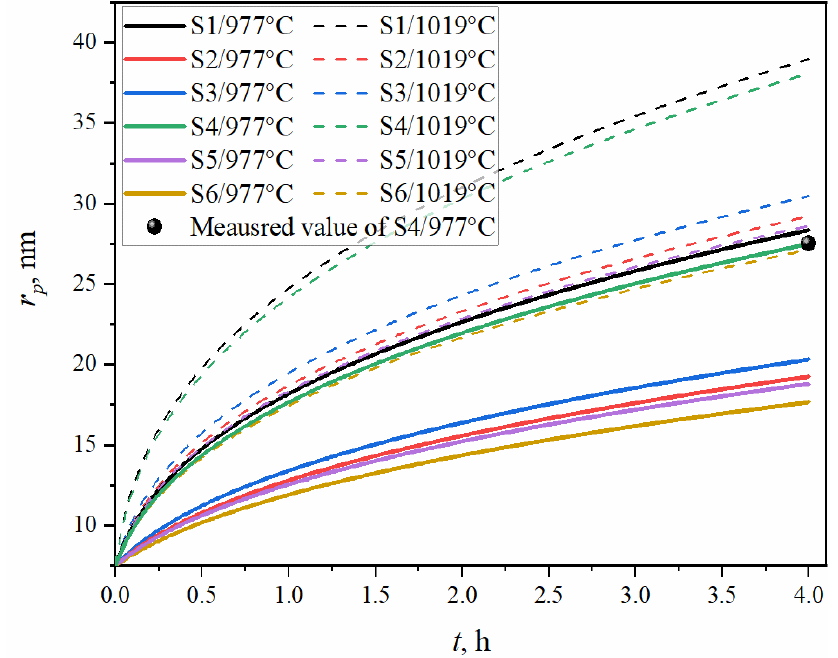
Figure 6. Calculated average radiuses of AlN particles as functions of time during carburizing at 977 and 1019 °C in various steels.